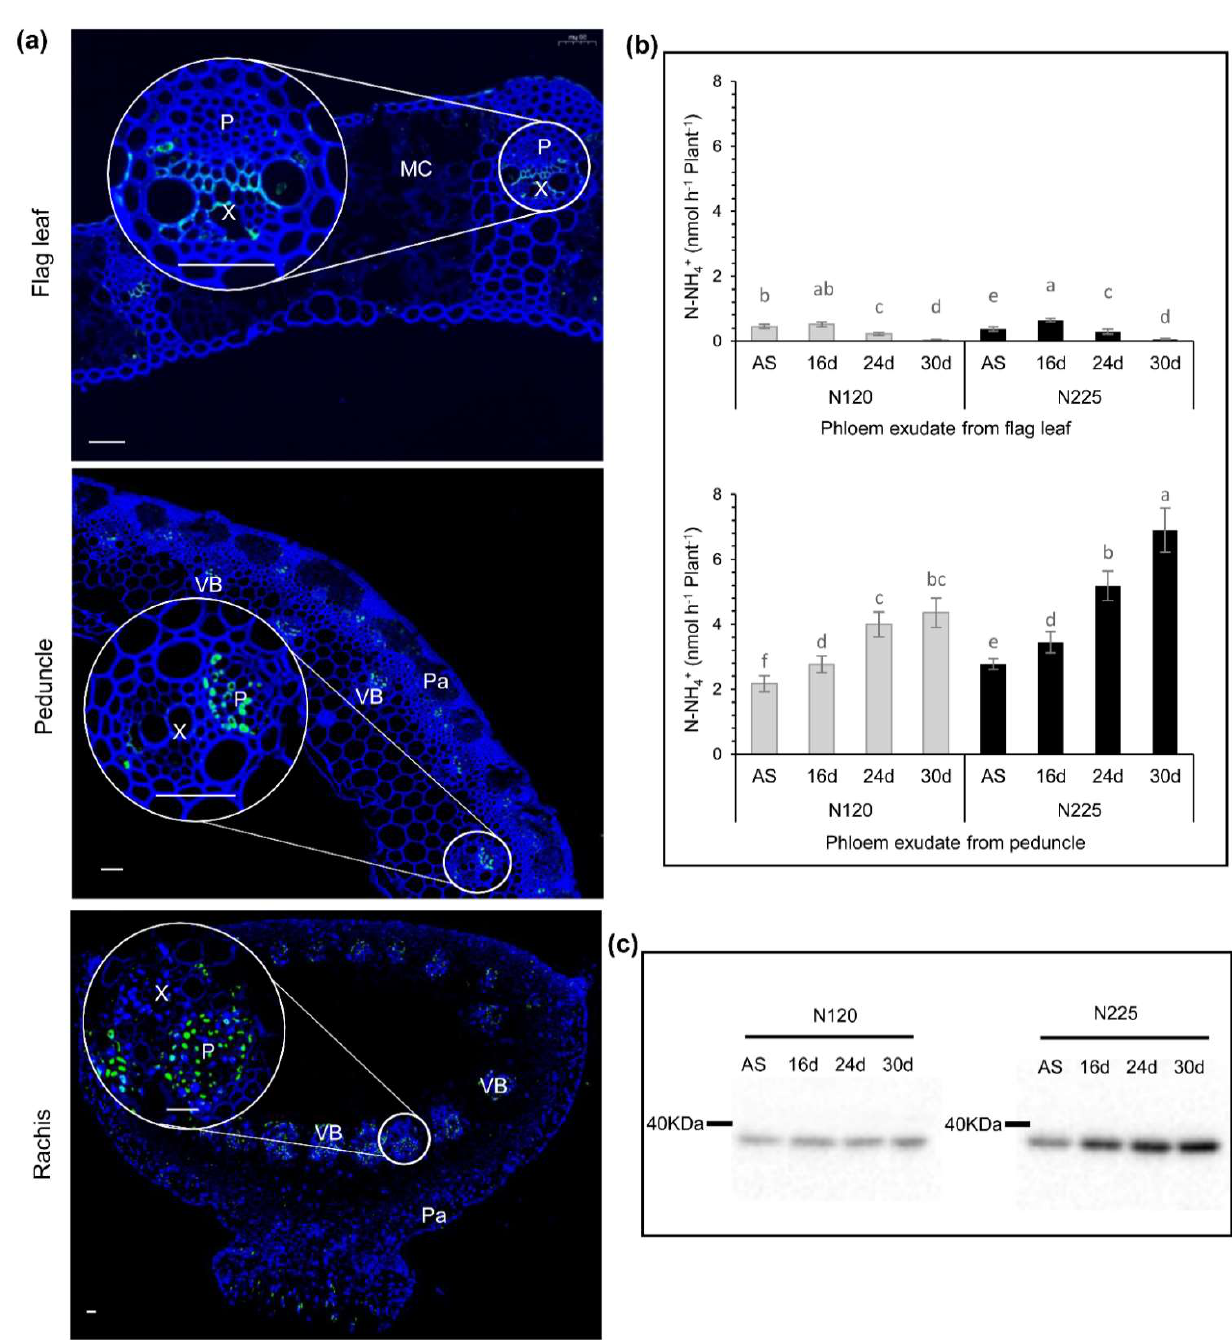
Figure 3. TaGS1;2 involved in nitrogen remobilization by NH 4+ assimilation in the phloem of wheat. ( a ) Histological immunolocalization of TaGS1;2 in flag leaf, peduncle, and rachis transverse section. P, phloem; X, xylem; VB, vascular bundle; Pa, parenchyma. Bars = 50 µ m. ( b ) The content of NH 4+ in the phloem exudate of flag leaf and peduncle during grain filling. Data are the means of six independent biological replicates ± SD. The different letters above each sample indicate statistically significant differences, where p < 0.05 according to one-way ANOVA and Duncan post-hoc test. ( c ) Western blot analysis of expression profile of subunits in rachis during grain filling grown under N120 and N225 conditions. A total of 5 μg of soluble proteins extracted from the rachis was loaded in each lane.